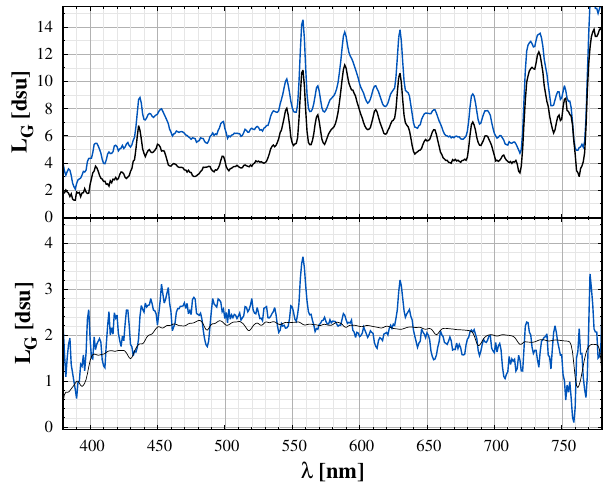
Figure 4. Top : Night sky spectrum with the zodiacal light (blue) and at a close sky location (black). The features of the light polluted sky is clearly visible, but the difference of the two spectra (lower panel, blue curve) emphasize only the zodiacal light and some components from airglow. The lower panel also displays the model of zodiacal light with black curve (Advanced Cerro Paranal Sky Model, see in Section